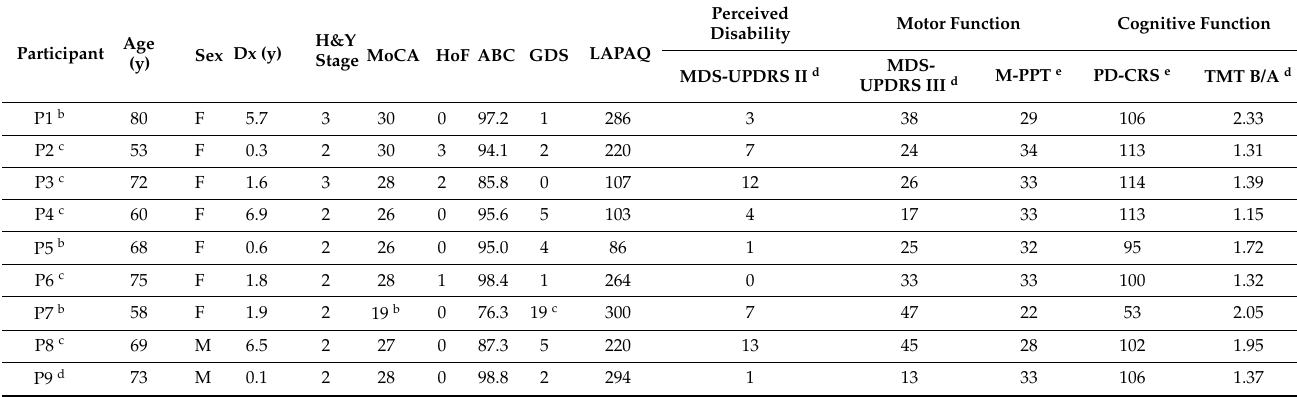
Table 1. Demographic, clinical, and baseline (T0) characteristics of enrolled participants a